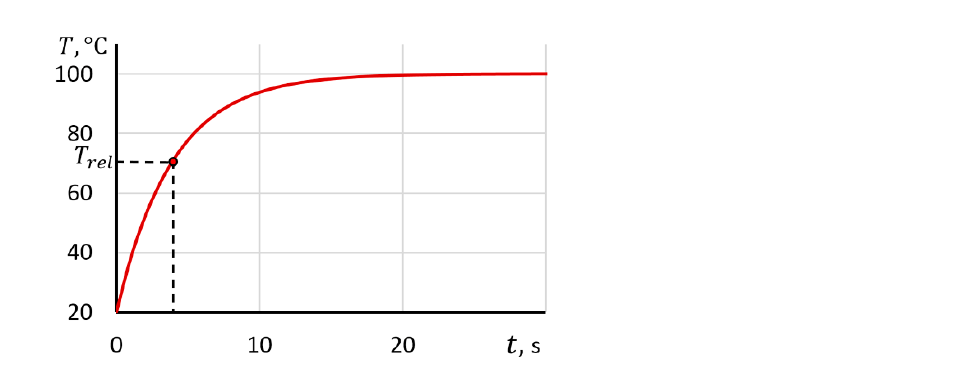
Figure 6. The temperature change vs time plot of the milk medium with the operation of the heater.